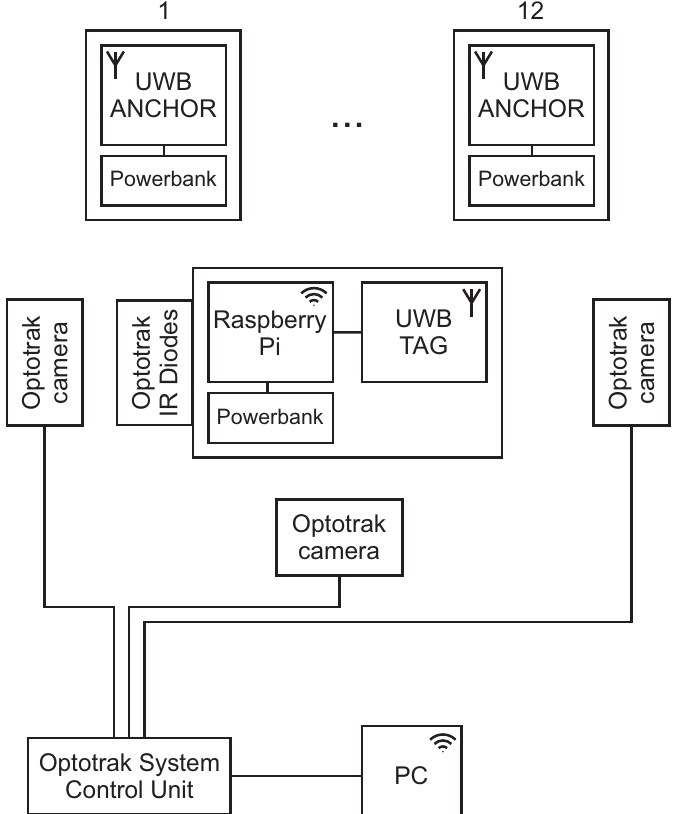
Figure 8. Experimental setup of 12 anchors and 1 tag for the model evaluation with the reference system Optotrak.